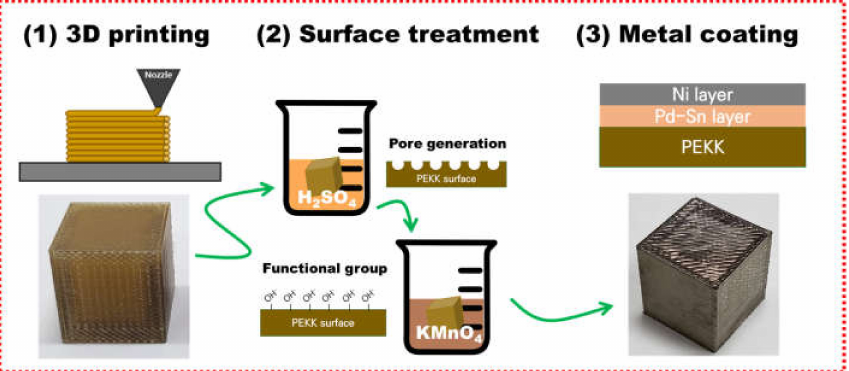
Figure 1. Illustration of metal coating on 3D printed PEKK.